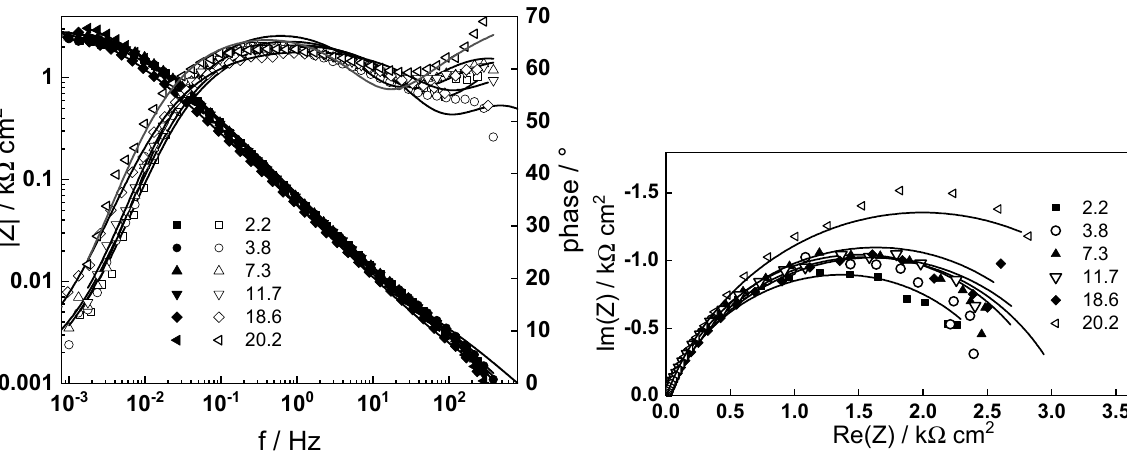
Figure 5. Electrochemical impedance spectra of AISI 316L at 180 ° С in AMETA without magnetite particles. ( left )—impedance magnitude (full symbols) and phase shift (open symbols) vs. frequency, ( right )—complex plane representation. Points—experimental data, solid lines—best-fit calculation with respect to the MCM equations discussed in the text. The legend is oxidation time (h).